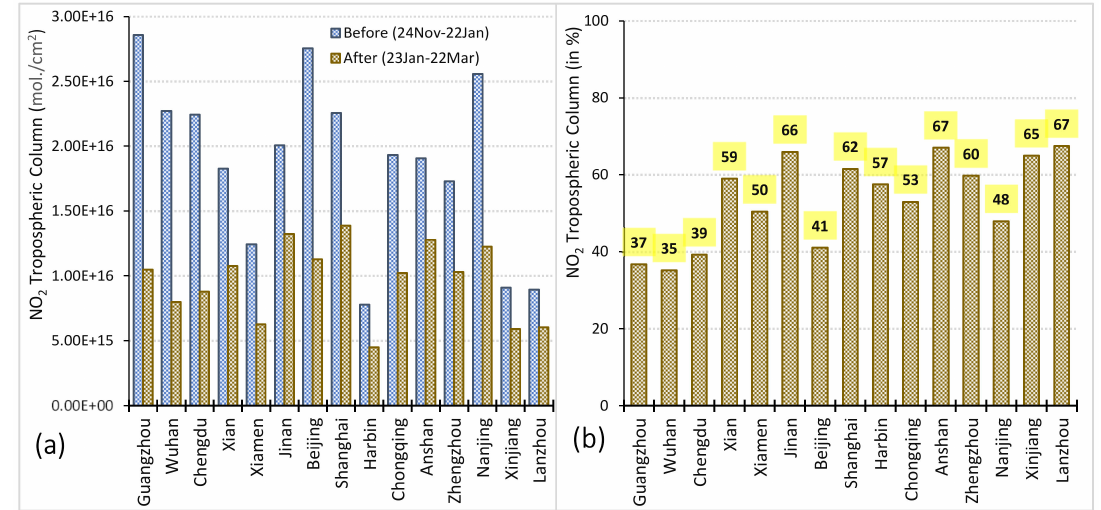
Figure 4. NO 2 tropospheric column of 15 major cities of China before and after the pandemic. ( a ) Absolute concentration and ( b ) decline in percentage. Source: Calculated by author,